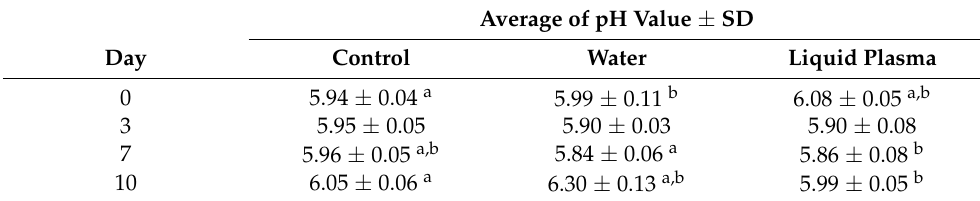
Table 8. Averages of the pH value of the inside of the chicken samples ( n = 9).